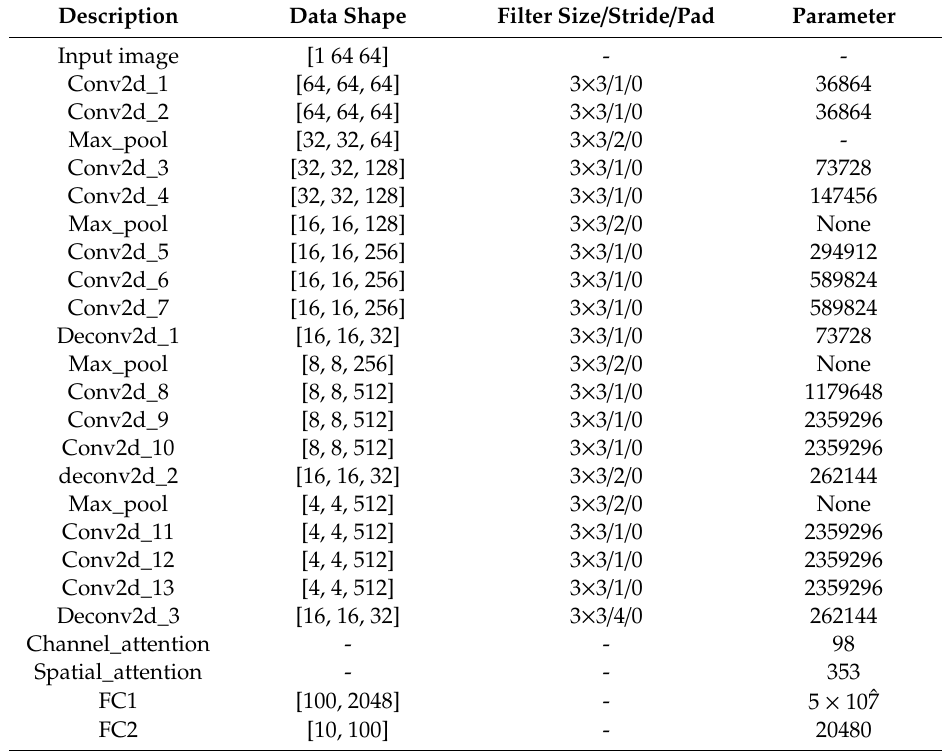
Table 1. Data analysis of proposed multi-level feature attention Synthetic Aperture Radar network